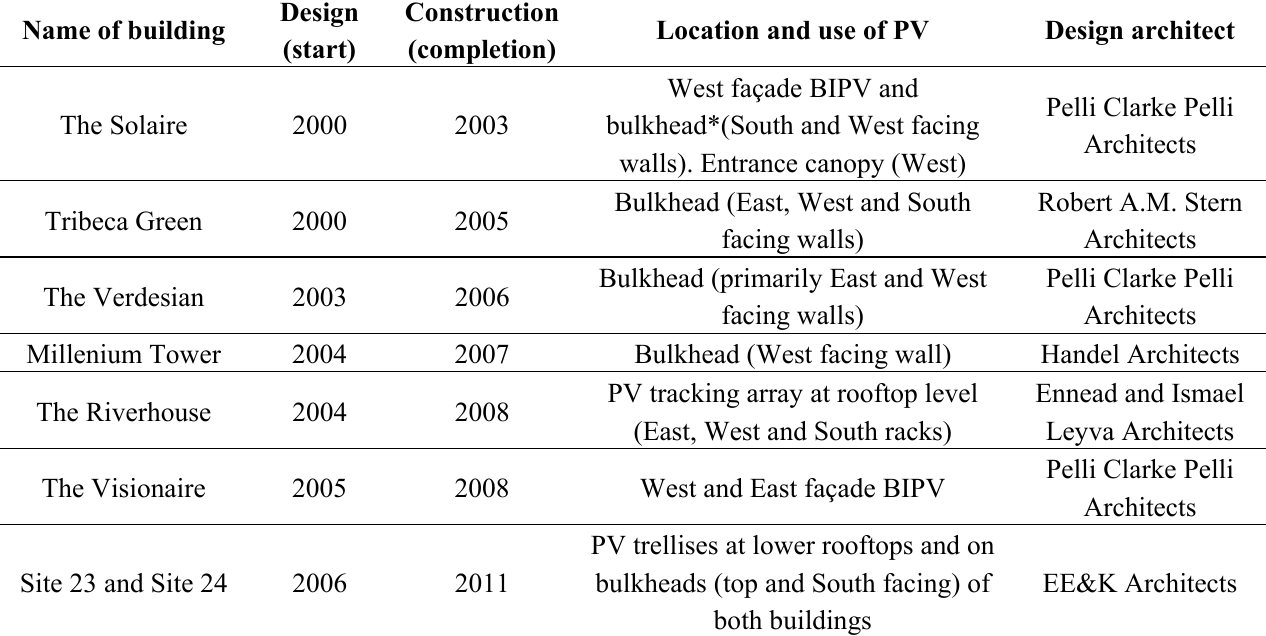
Table 1. Battery Park City (BPC) buildings under